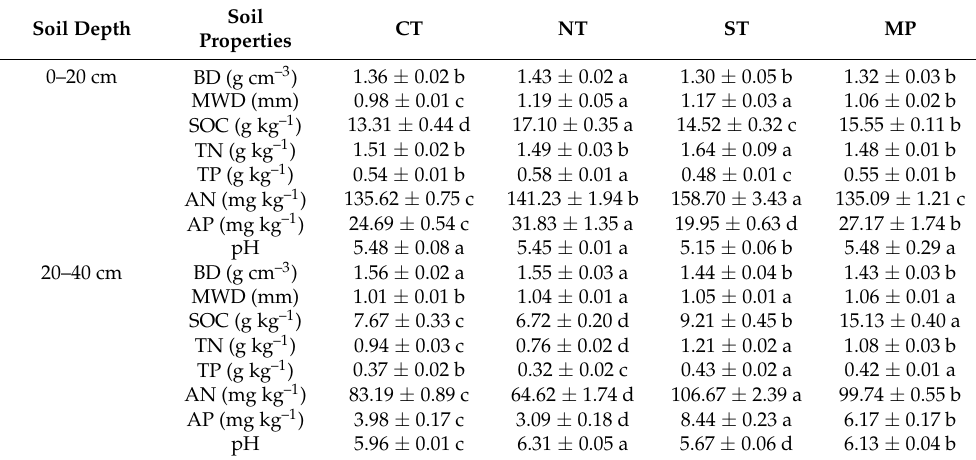
Table 1. Soil physicochemical properties of 0–40 cm soil layer under different tillage practices. Soil